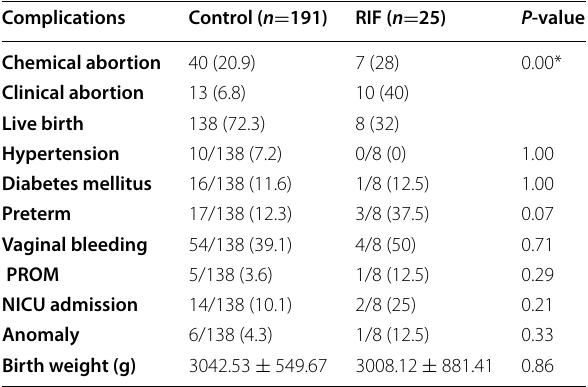
Table 3 Rates of obstetric and perinatal complications in control and RIF patients of the fresh ET cycles ( n